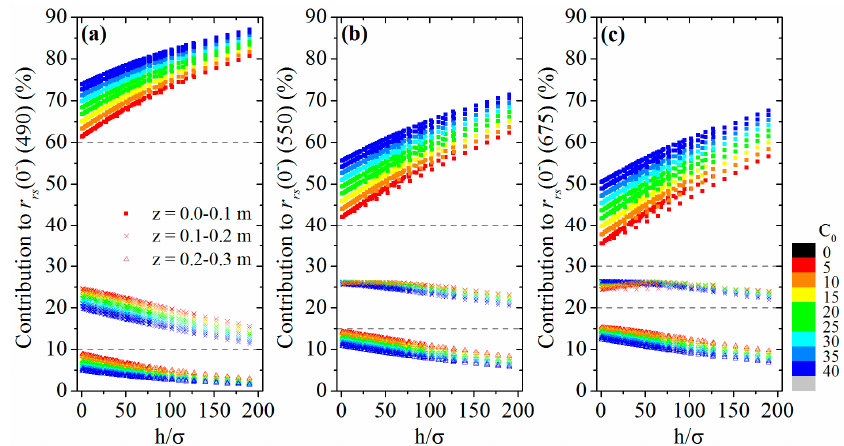
Figure 9. Contribution of each layer to r rs (0 − ) on different vertical structure parameters (C 0 , h/ σ ) at z = 0.1, 0.2, 0.3 m: ( a ) 490 nm, ( b ) 550 nm, ( c ) 675 nm. It indicated that the first three layers would contribute about 90% to r rs (0 − ).